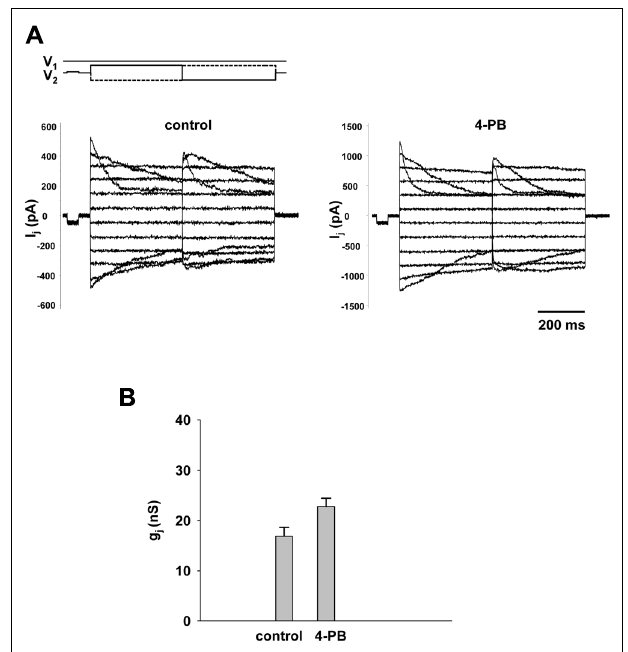
FIGURE 3 | Macroscopic properties of gap junction channels. (A) Gap junction currents ( I j ) elicited from HEK-293 cells by bipolar V j pulses ( V 1 and V 2 ; top panel) in control pairs (left panel) and cell pairs with 4-PB exposure (right panel). (B) Average of gap junction conductance for 4-PB treated (22.7 ± 1.7 nS, n = 31 cell pairs) and control (16.9 ± 1.8 nS, n = 32 cell pairs), p =